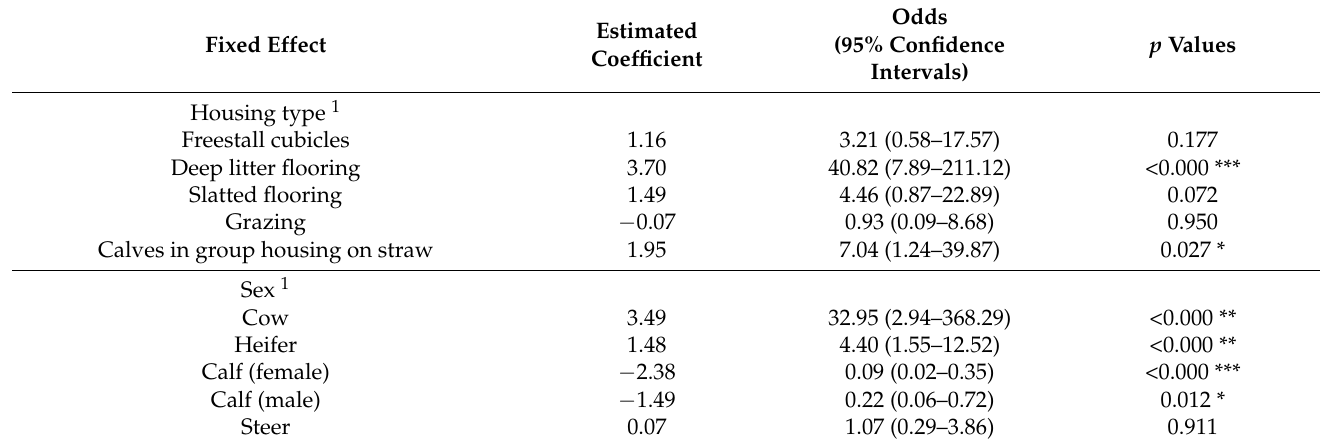
Table 3. Estimated significant influencing fixed factors (including associated odds) for the contamina- tion of the slaughtered cattle compared to the